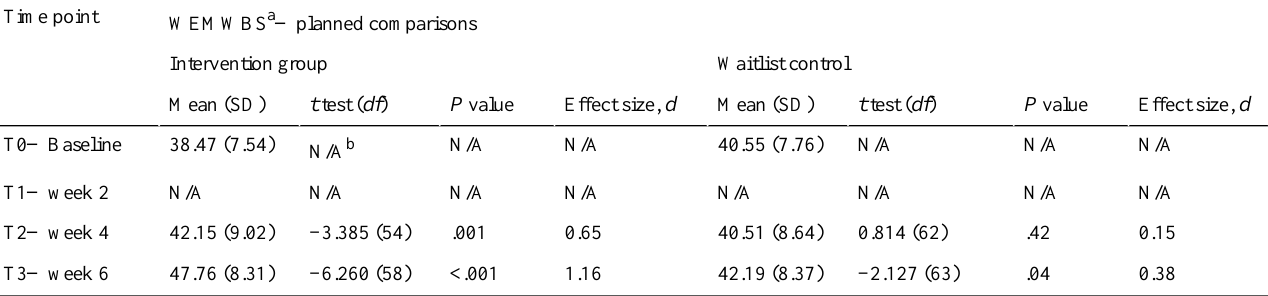
Table 5. Mean, SD, and planned comparisons on Warwick-Edinburgh Mental Well-Being Scale scores over the duration of the study (T0, T1, T2, and T3) in the intervention and waitlist control